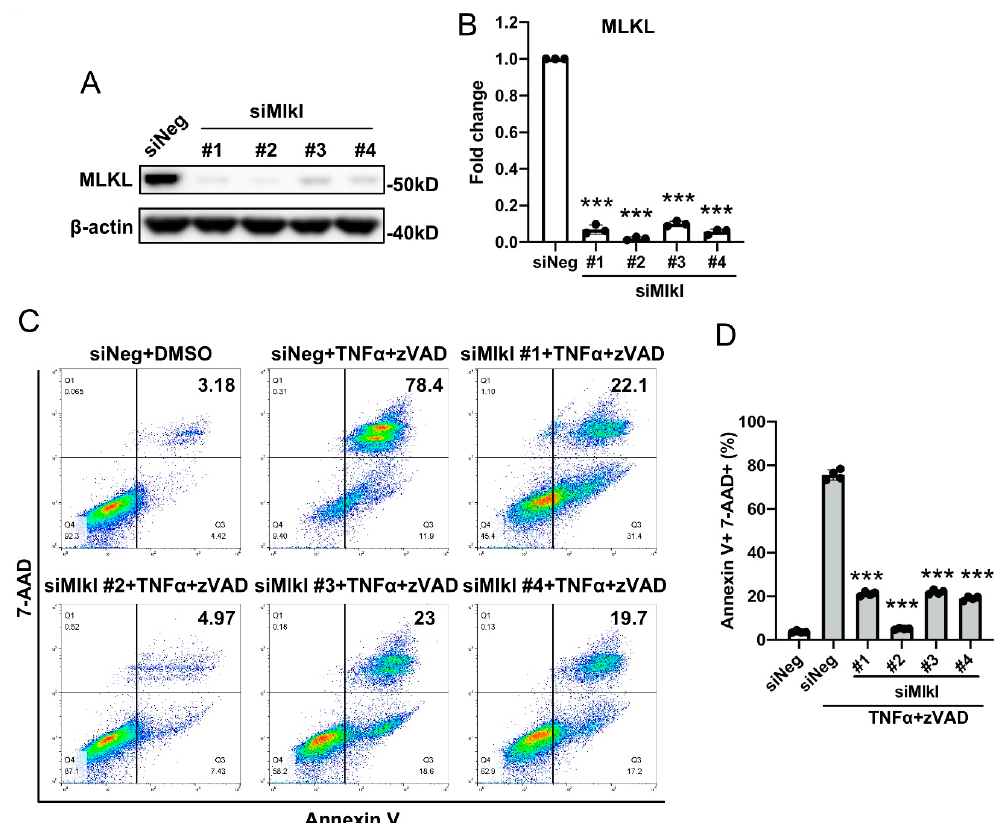
Figure 3. MLKL plays an essential role in SMC necroptosis. MOVAS cells were transfected with siRNAs against Mlkl for 48 h. ( A , B ) Validation of siRNA knockdown by Western blotting. ( C ) Following Mlkl knockdown, MOVAS cells were treated with 30 ng/mL TNF α plus 60 µ M zVAD for 6 h. Cells were then stained with 7-AAD and Annexin V, and analyzed by flow cytometry. Necrotic cells were identified as 7-AAD + Annexin V + . ( D ) Quantification of ( C ). Data were presented as mean ± SD of at least three independent experiments. One-way ANOVA was performed in ( B , D ). *** p <